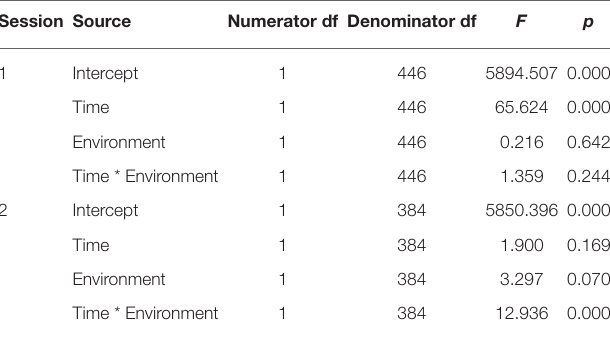
TABLE 11 | Effects † of time (pre, post) × environment (nature, urban) on BDS, in 1st vs. 2nd test sessions, including all study samples. Session